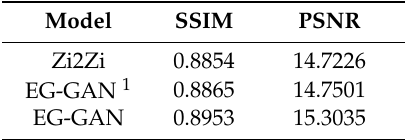
Table 3. Comparison of objective image quality metrics (SSIM, PSNR) of the proposed model.